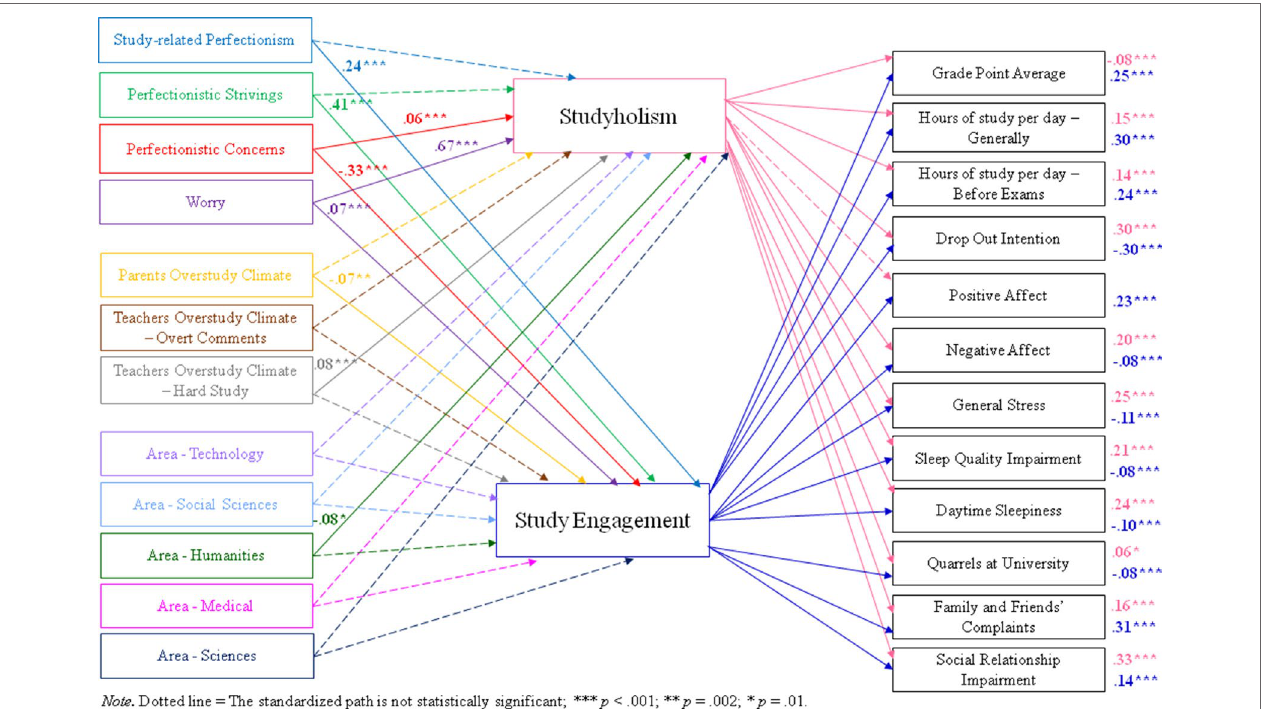
FIGURE 3 | Structural model with standardized path estimates for Studyholism and Study Engagement antecedents and outcomes (n =